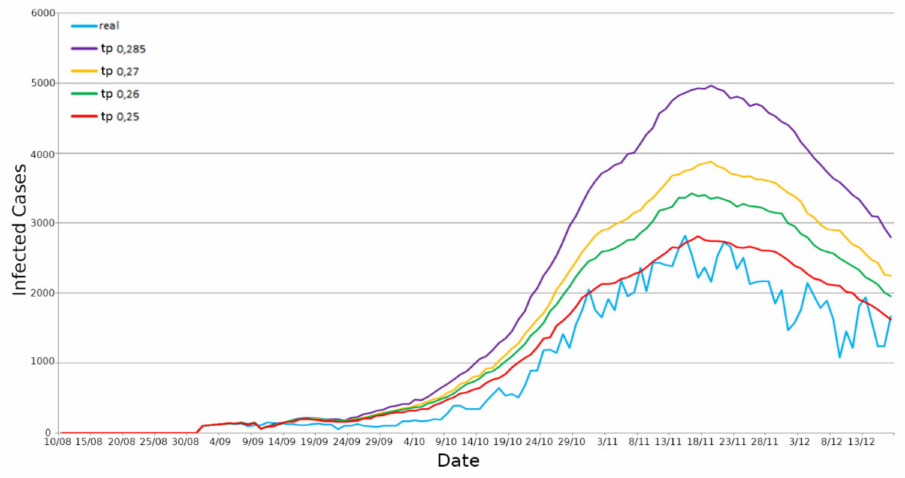
Figure 9. Graph of daily infected persons with different TP values—Emilia Romagna